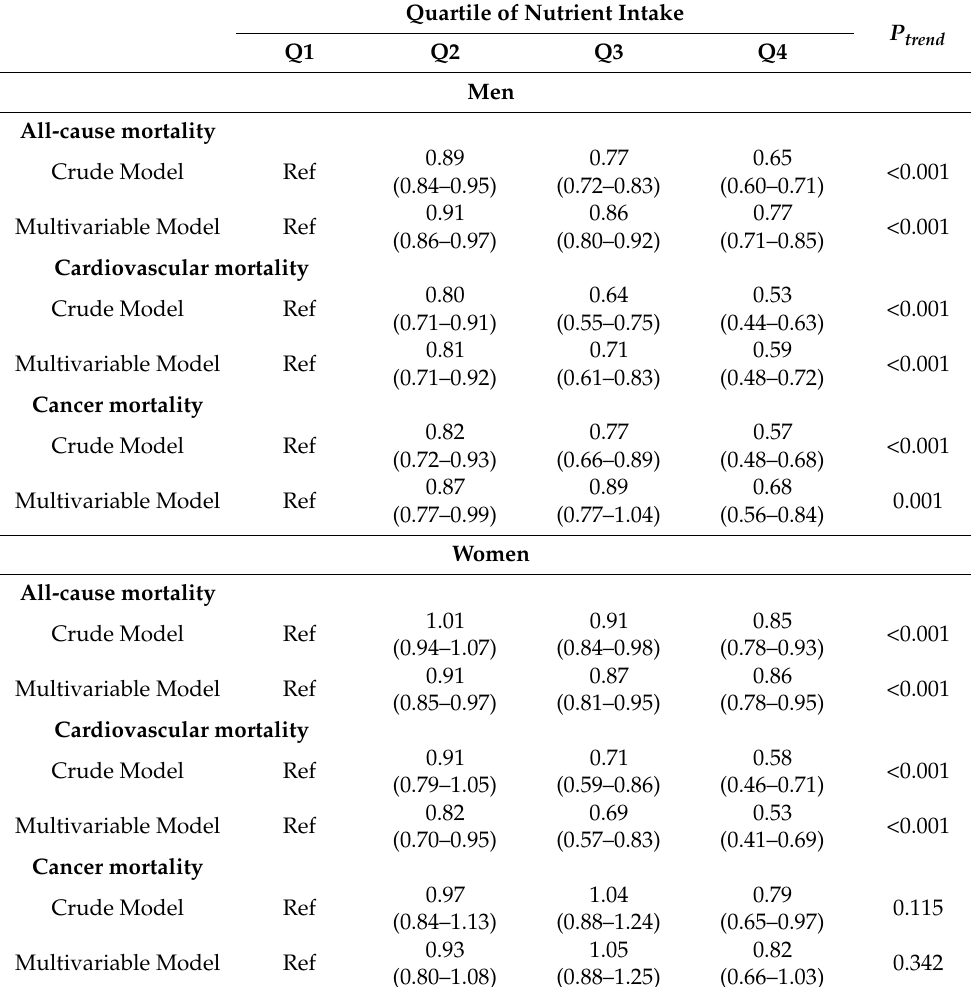
Quartile of Nutrient Intake